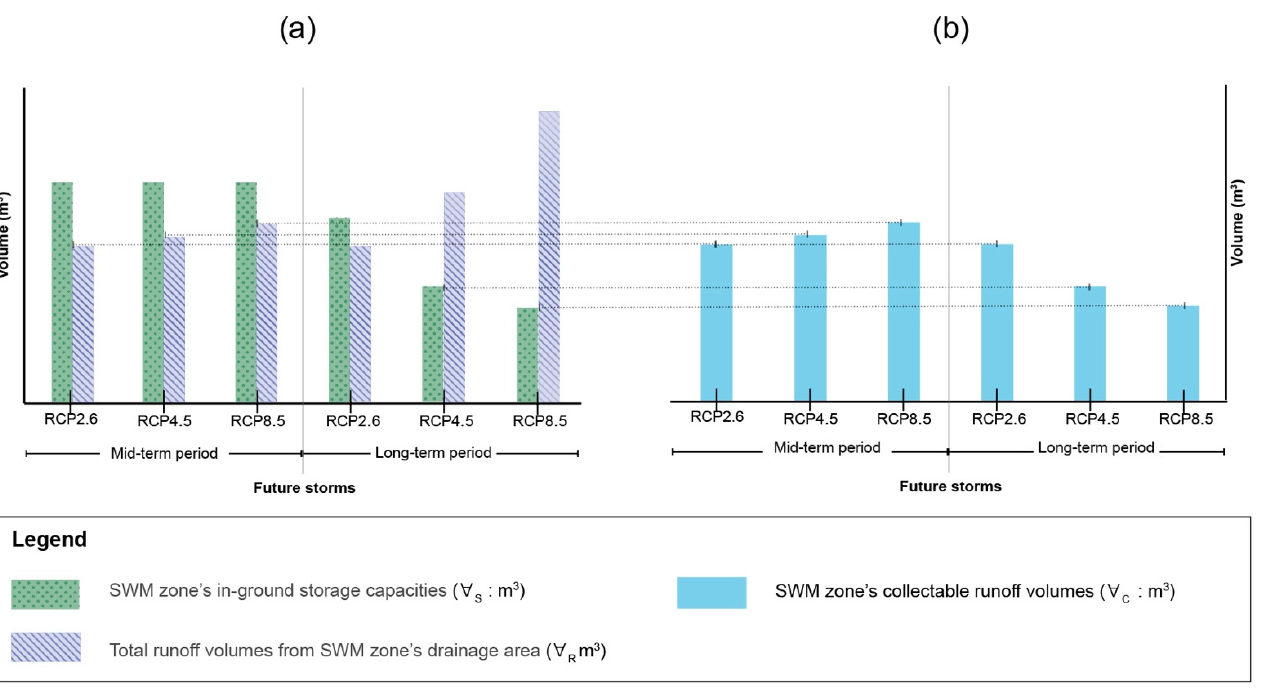
Figure 5. The zone’s in-ground storage capacity (green bar) is compared with the total runoff volumes from the drainage area (blue bar) by climate change scenarios and periods ( a ) to determine the collectable runoff volumes of Zone 1A ( b ).